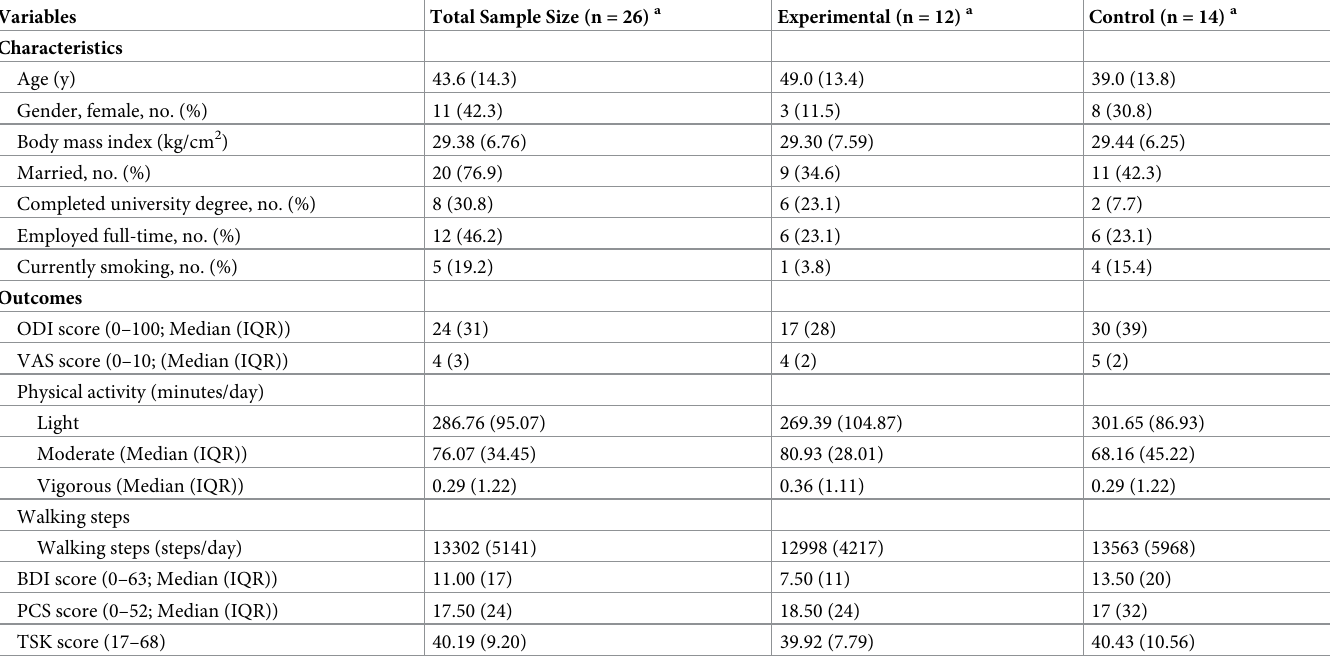
Table 2. Participants demographics and outcome measures variables at